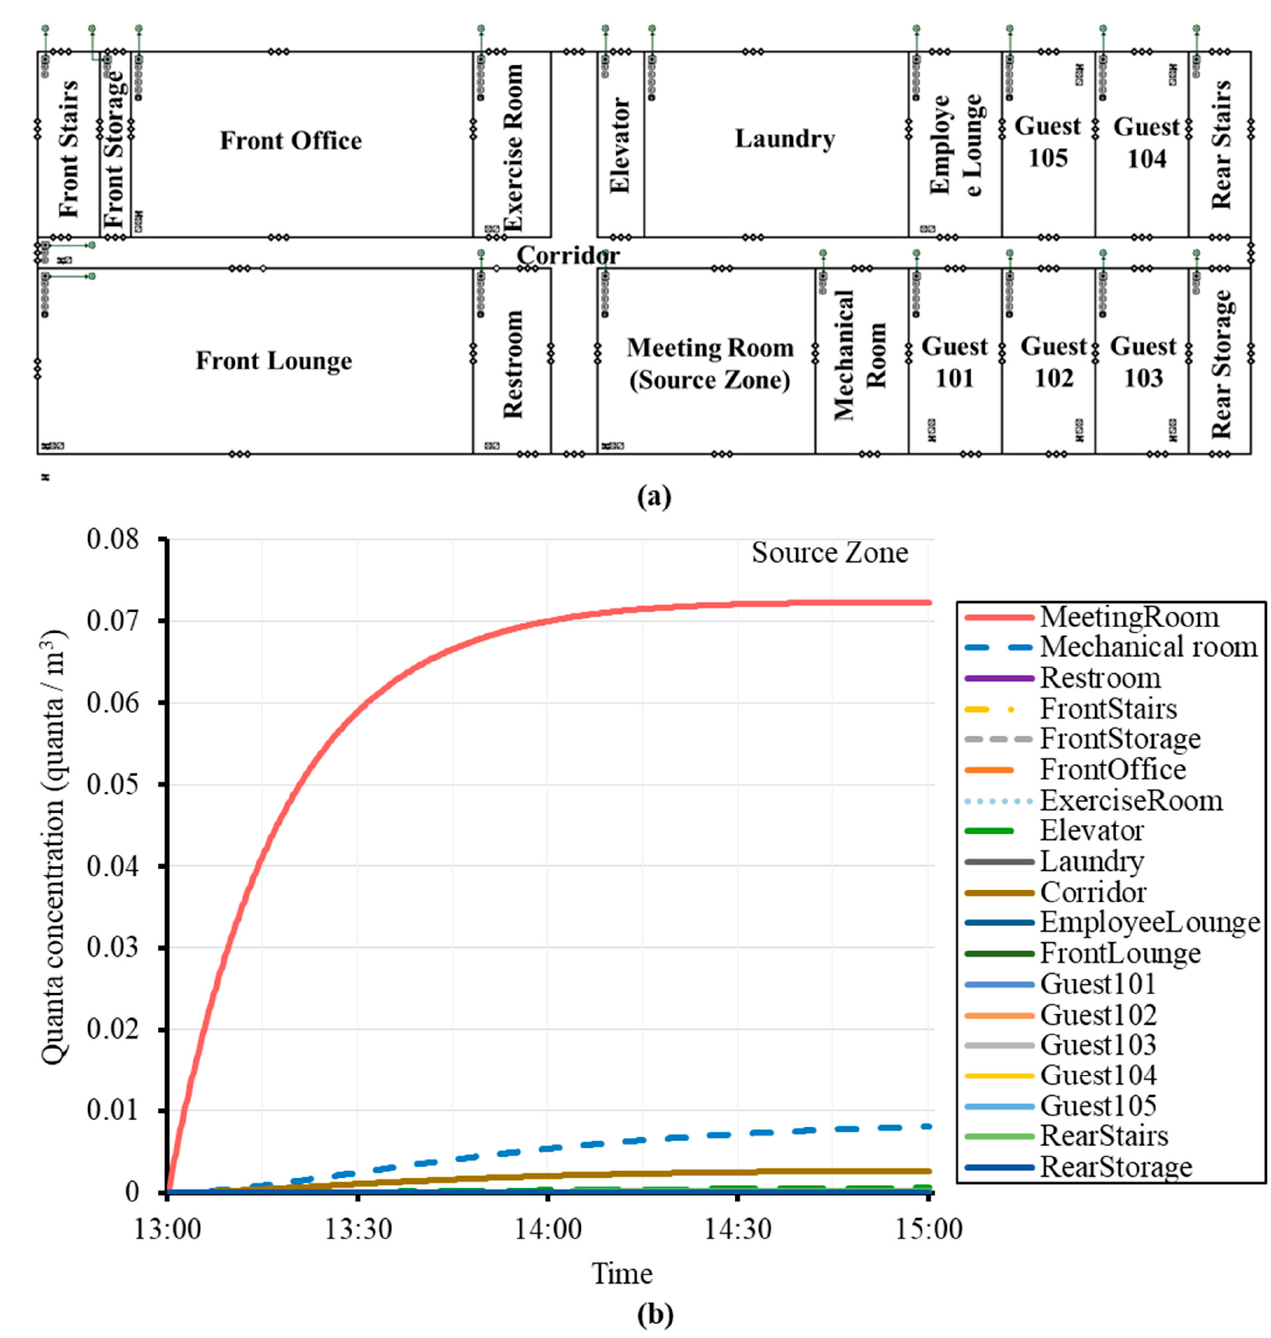
Figure 8. Small Hotel ( a ) top-view diagram of the Small Hotel 1 st floor and ( b ) quanta concentration as a function of time during a workday with the infector in the core zone on the first floor. Small icons in each room were contaminant generation source, deposition/deactivation items, and the supply/return of HVAC systems (small symbols).